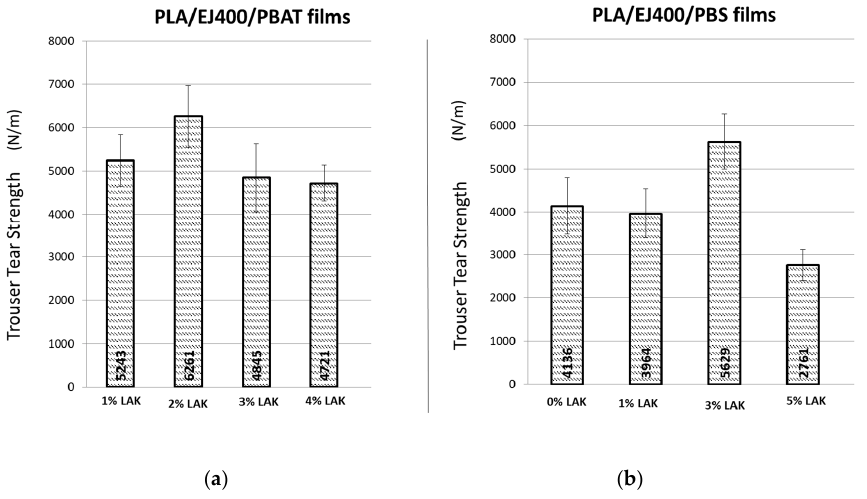
Figure 3. Trouser tear tests related to blown extruded film: ( a ) PLA/EJ400/PBAT films; ( b ) PLA/Ej400/PBS films. Table 3. DMTA results about blends based on PLA/EJ400/PBS.